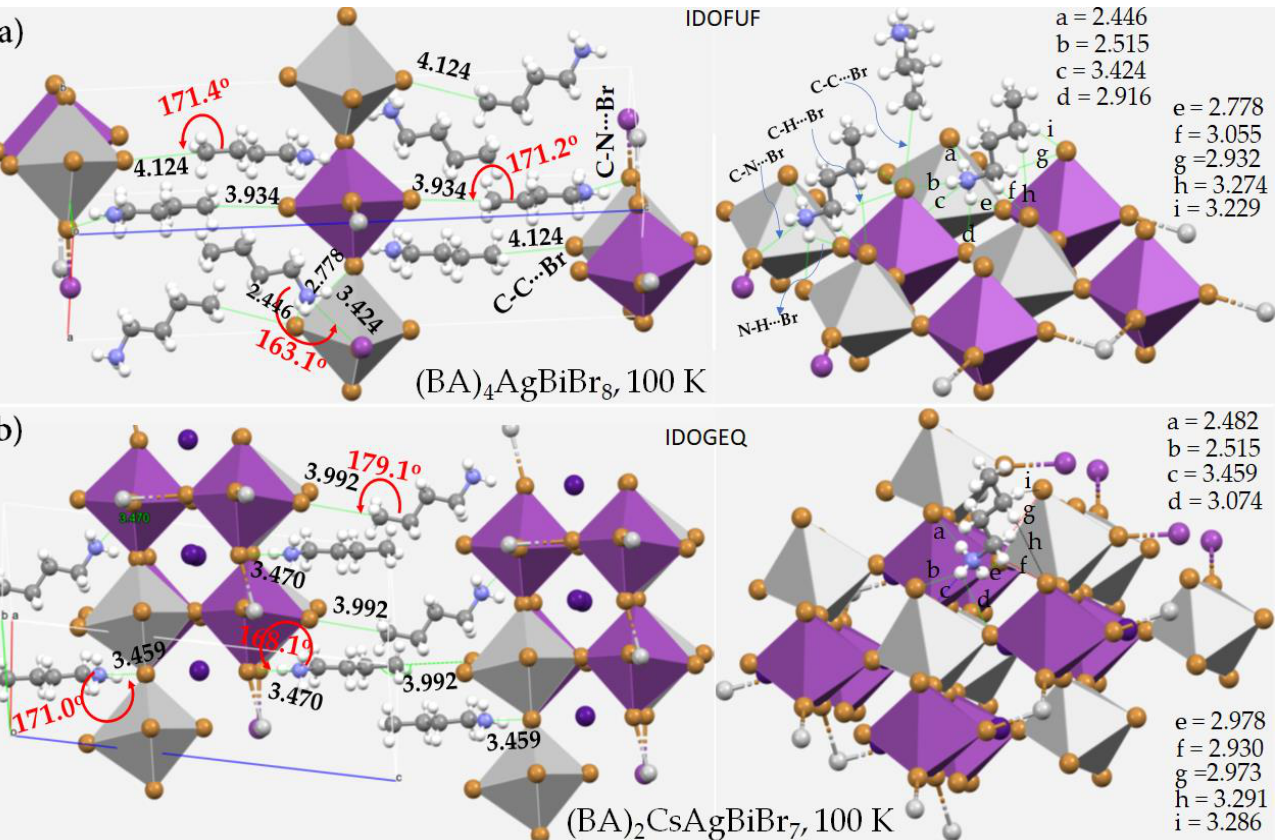
Figure 21. Polyhedral and ball-and-stick models of ( a ) (BA) 4 AgBiBr 8 and ( b ) (BA) 2 CsAgBiBr 7 (BA = CH 3 (CH 2 ) 3 NH 3+ ), displaying the nature of pnictogen- and tetrel-bonding interactions in the crystal. Shown on the right of ( a , b ) are the illustration of local modes of various interlayer intermolecular interactions (viz. hydrogen bonds, tetral bonds, and pnictogen bonds) formed between the inorganic and organic frameworks. Selected bond distances and bond angles are in Å and degrees, respectively. Some of the organic cations in ( b ) have been deleted for clarity. The CSD references are shown in each case in uppercase letters. The purple and white-gray octahedra correspond to BiBr 6 and AgBr 6 octahedra, respectively, whereas the dark-purple balls inside the cage in ( b ) represent the cesium cations.